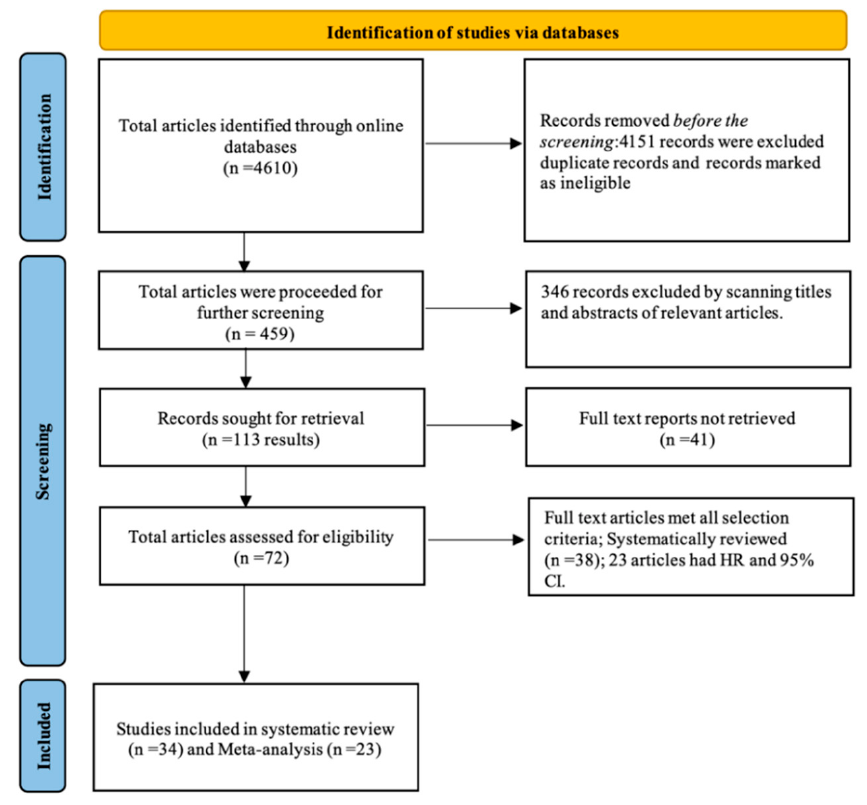
Figure 1. Flow chart of the literature search.